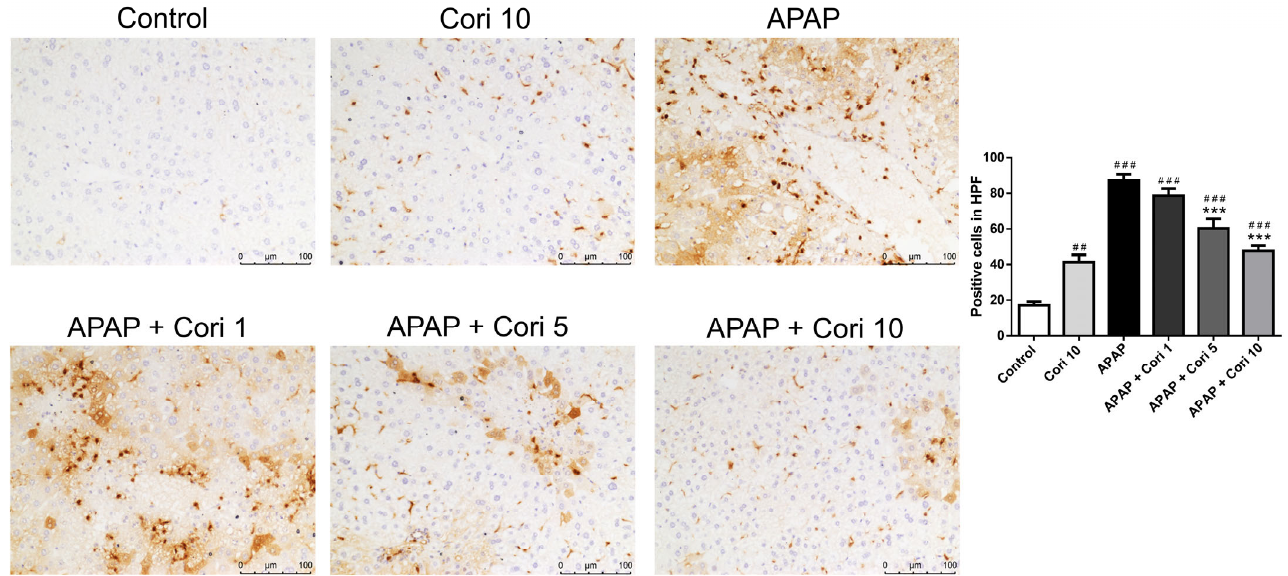
Figure 3. The effects of corilagin on macrophage infiltration in acetaminophen-induced hepatic injury. Animals were injected with APAP (300 mg/kg) or equal volume of saline (control), and treated with corilagin (0, 1, 5, or 10 g/kg) (200×). Each value represents mean ± SEM; n = 6 for each group. ## p < 0.01, ### p < 0.005 vs. control group; *** p < 0.005 vs. APAP group.